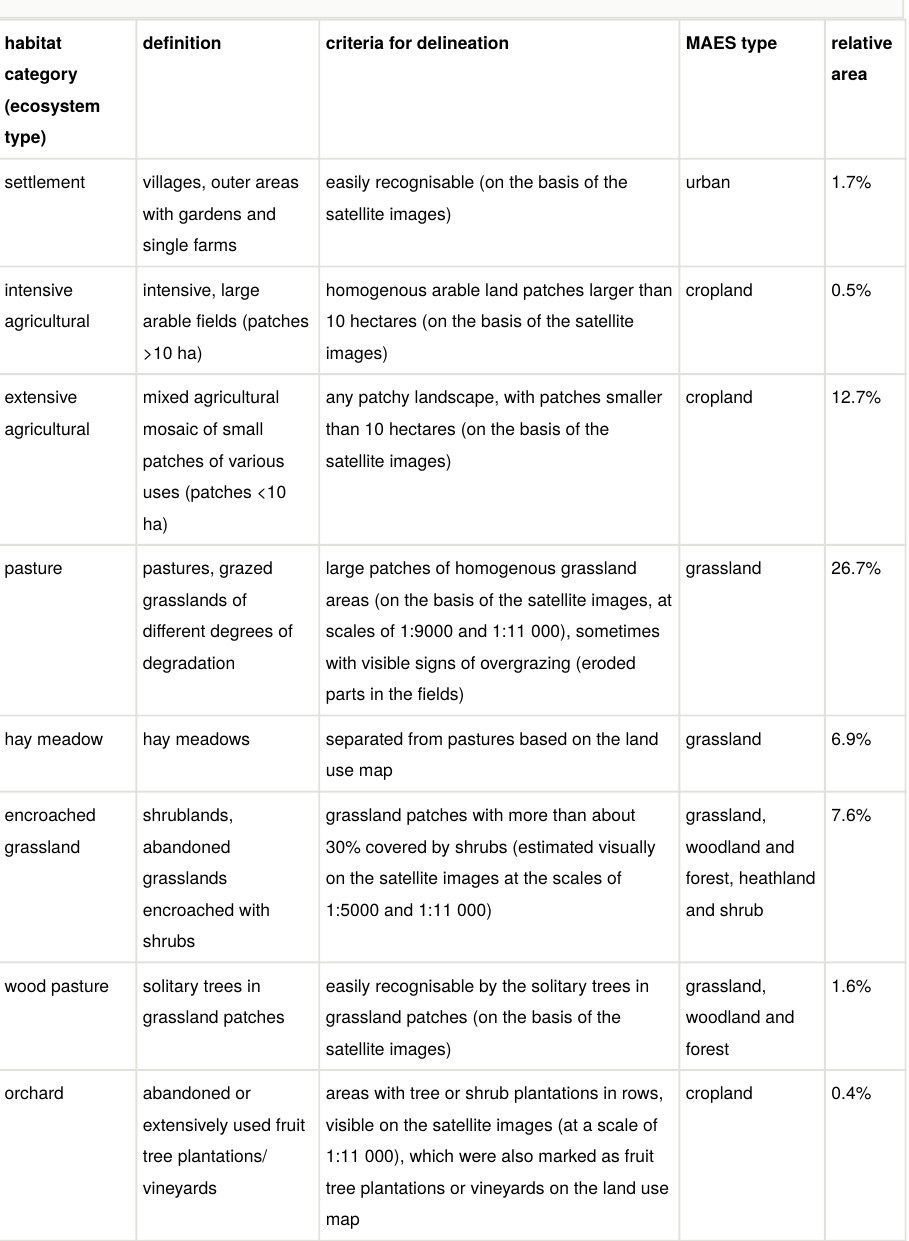
The fi nal list of ecosystem (or habitat) types distinguished in our ecosystem map. MAES types follow Maes et